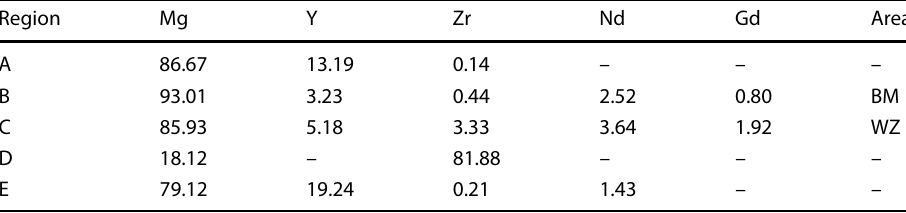
Table 3 EDS results of regions in Fig. 4 (%, mole fraction)